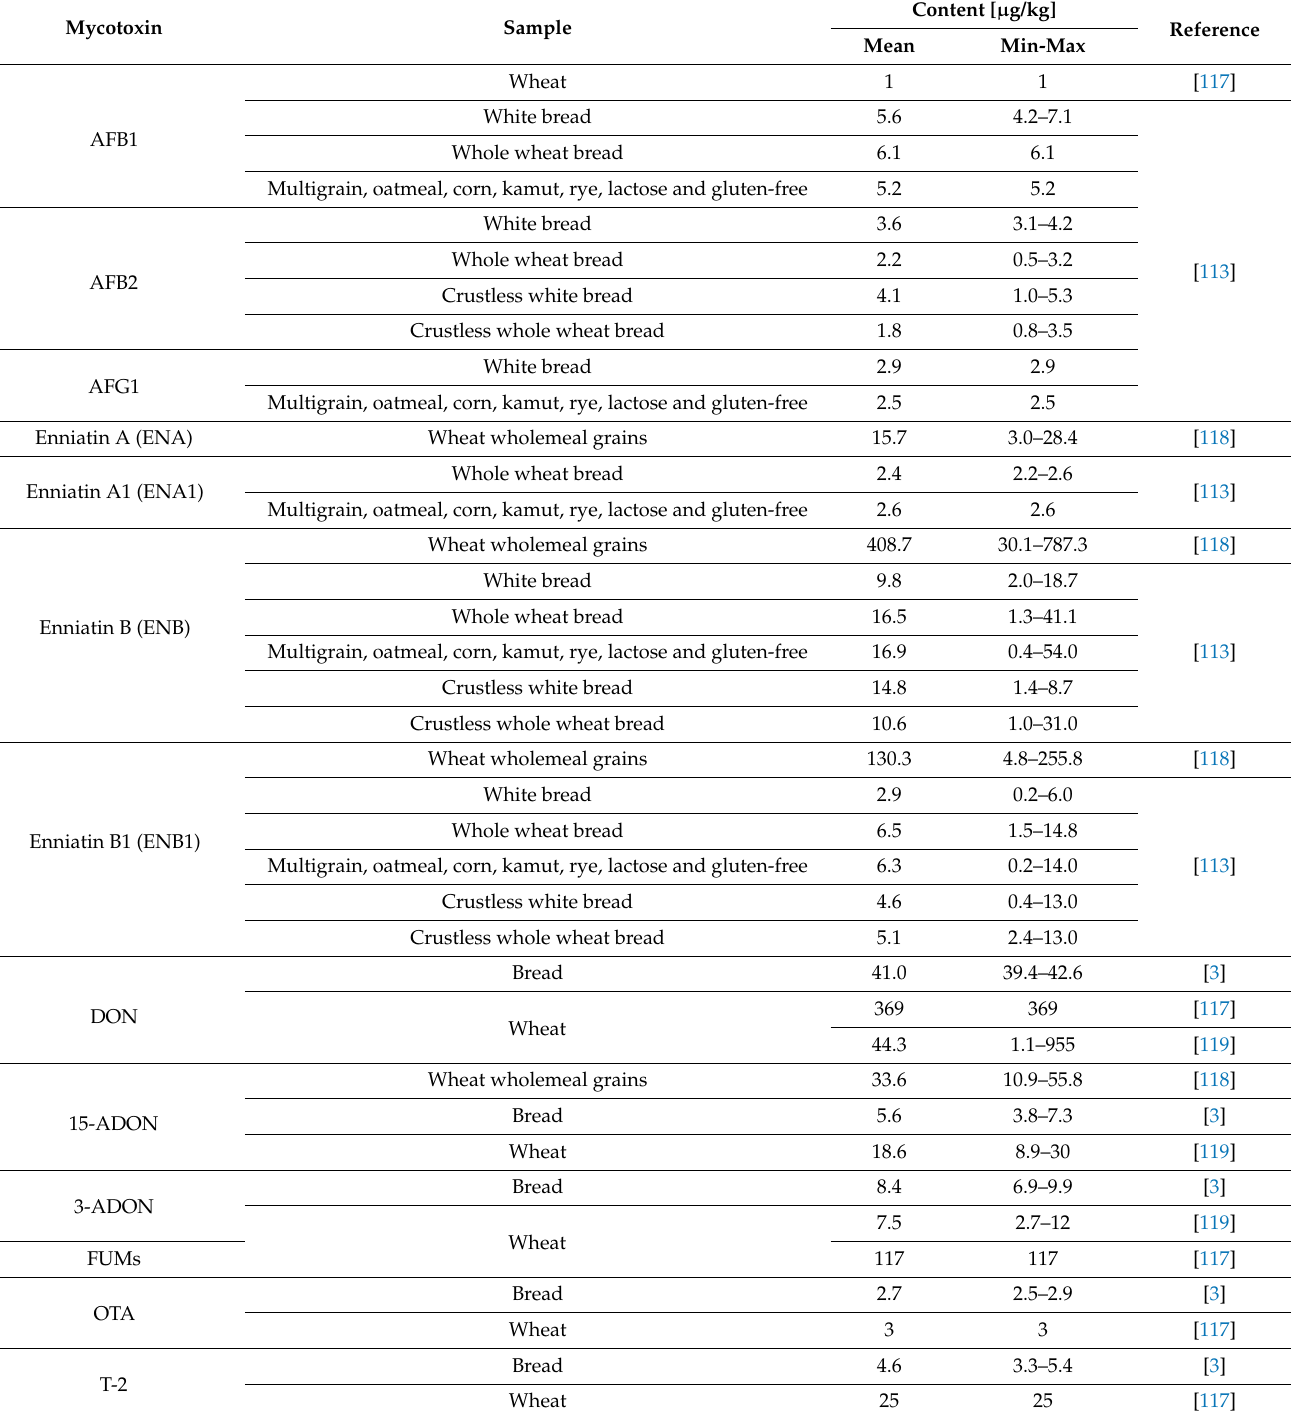
Table 3. Up-to-date research on mycotoxins’ presence in different wheat-based